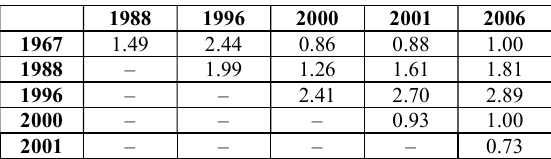
Table 3. RMSE after M3C2 comparison of point clouds in five stable areas from different epochs (results in